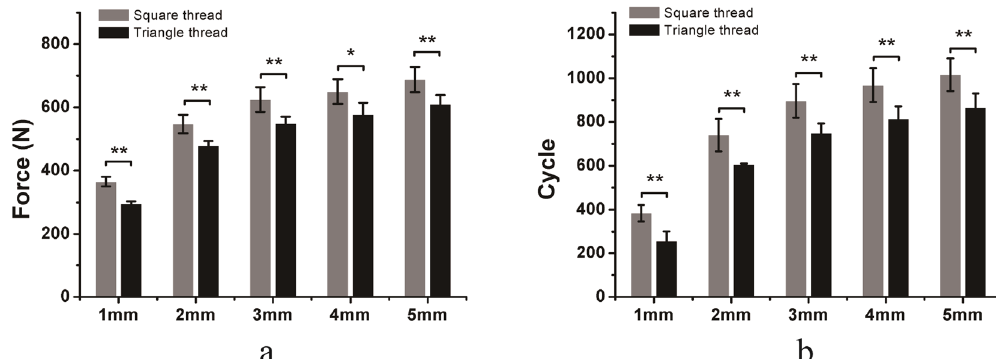
Figure 5. Comparison of the force ( a ) and number of cycles ( b ) required to achieve a 1, 2, 3, 4, and 5 mm displacement of the locking screws (LP fixation) with square thread and triangle thread under cyclic craniocaudal loading. Mean values ± standard deviation of the measured values are presented (N = 5) (Student’s t-test, *p < 0.05, **p < 0.01).